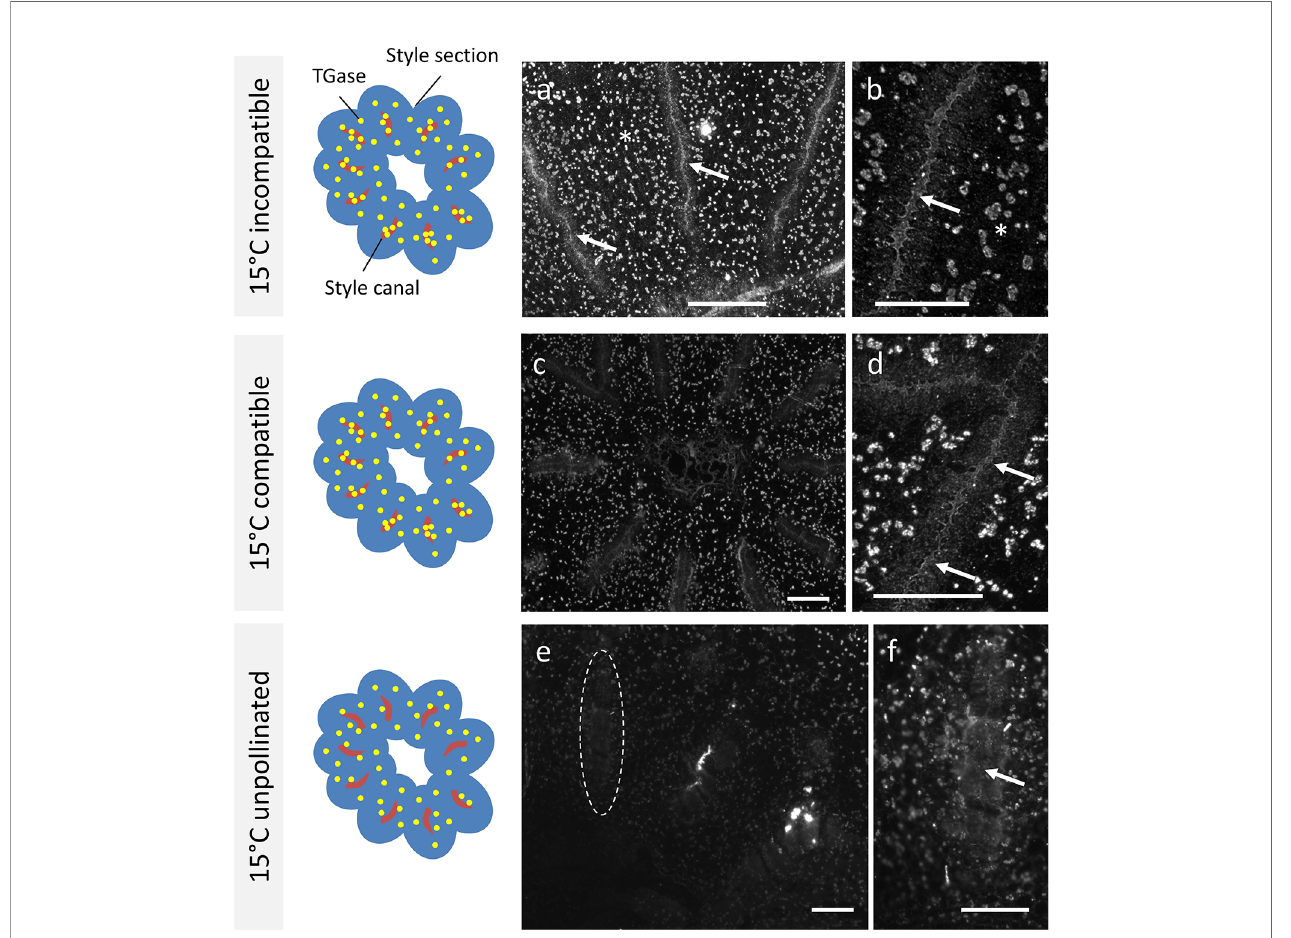
FIGURE 4 | Immunolocalization of TGase during pollen germination in planta at 15°C. Distribution of TGase in compatible, incompatible, pollinated, and unpollinated styles, crossed at 15°C. Again, in each reported case the left-hand drawing schematically depicts the style cross-section (in blue), the stylar canals (in red) and the pattern of TGase (yellow spots). (A) In the incompatible crosses, an intense TGase signal can be observed in the style canal (arrows) but also externally in the form of diffuse spots (asterisks). (B) Detail of a style canal with clear accumulation of TGase internally (arrow). (C) In the compatible crosses, a clear TGase signal was observed inside the style canal and TGase was also distributed externally as diffuse spots. (D) Detail of a style canal with an intense internal TGase signal (arrows) and with a diffuse external signal. (E) In unpollinated styles (E) no TGase signal was present inside the style canal (indicated by the dotted oval); a diffuse faint signal was observed externally. (F) Detail of a style canal with no signal inside. Scale bars: 100 m